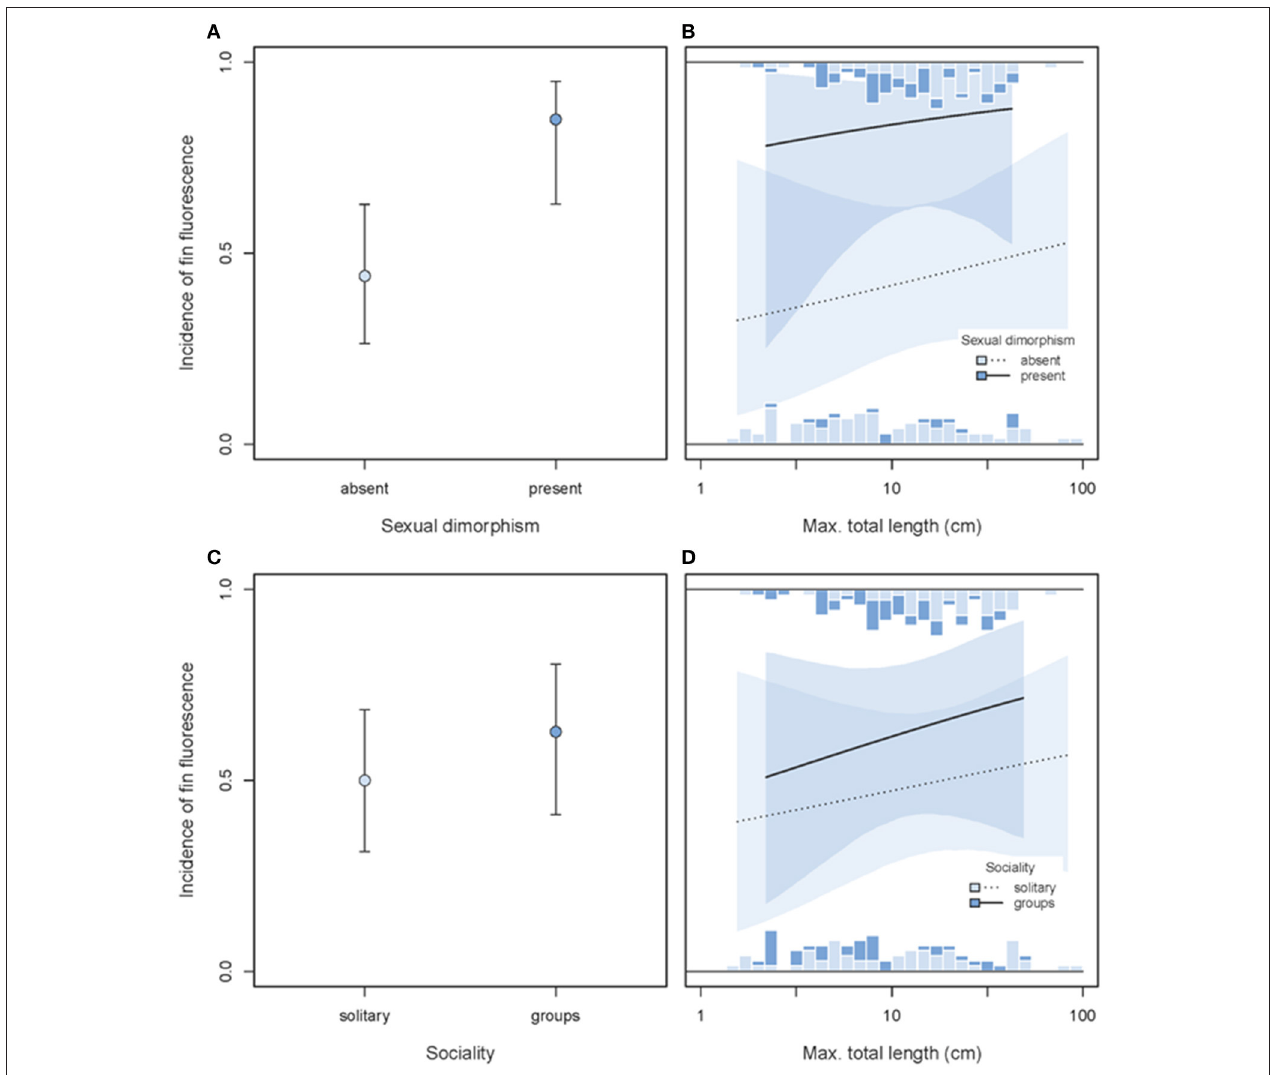
FIGURE 13 | Incidence of fin fluorescence as predicted by sexual dimorphism (A,B) or sociality (C,D) and maximum body length ( x -axis). In each row, the left panel illustrates the overall predicted incidences of fin fluorescence ( ± 95% credibility intervals), pooled across body size. The right panel illustrates the interaction between sexual dimorphism or social system and body length (note log 10 -scale). Stacked marginal histograms display the relative frequency distribution of raw species values. Predicted incidences (lines) and their 95% credibility intervals (shaded areas) are extracted from binomial models taking shared species ancestry into